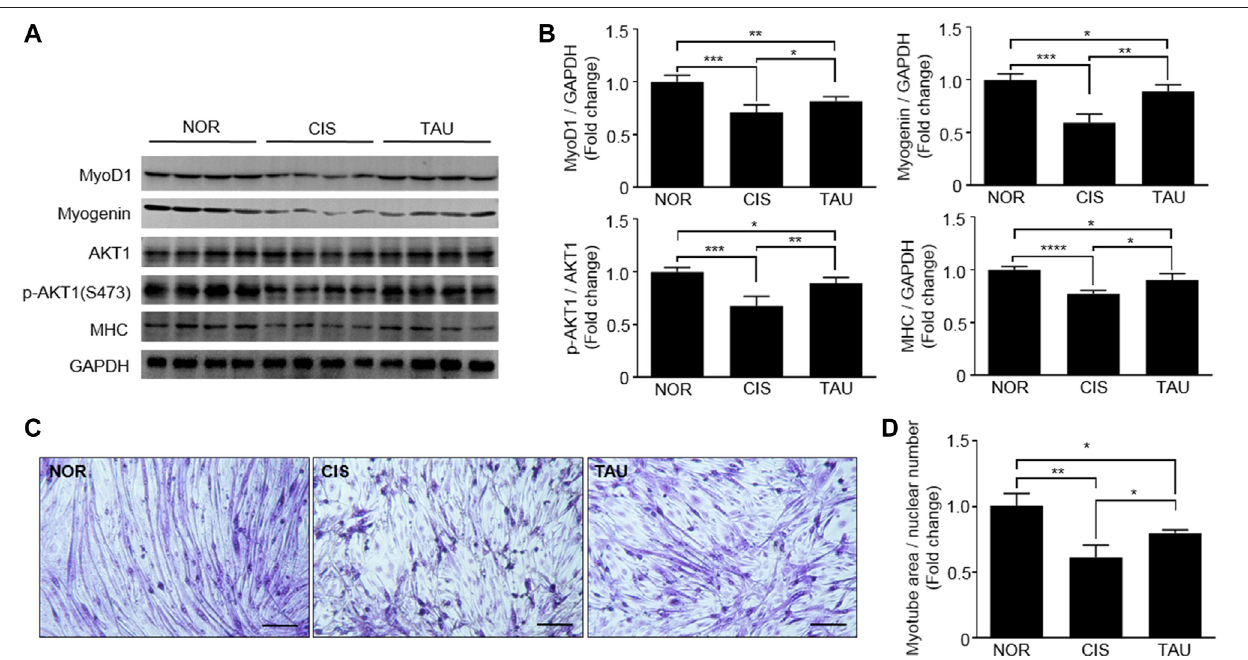
FIGURE 3 | Taurine supplementation preserved the myotube differentiation ability of C2C12 myoblasts. (A, B) Expression of MyoD1, myogenin, AKT1, phospho- AKT1(ser473),andMHCinthethreegroupsofC2C12myoblasts( n (cid:2) 8). (C) Representativemorphologicalimages ofnormalcontrol(NOR) myotubes,cisplatin-treated (CIS) myotubes, and taurine-supplemented (TAU) myotubes (20 × ). Scale bar, 100 µm. (D) Relative myotube area. All experiments were conducted on three separate occasions ( n (cid:2) 3); 4 – 5 morphological images per condition in duplicate were analyzed for each occasion. The total area of myotubes was normalized to nuclear